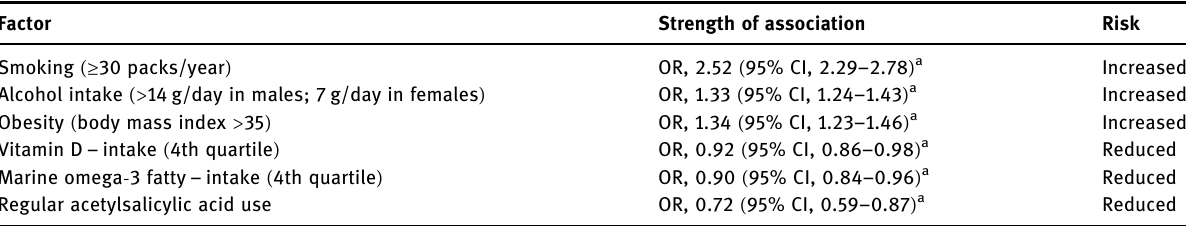
Table 1: Factors associated with the development of serrated lesions Factor Strength of